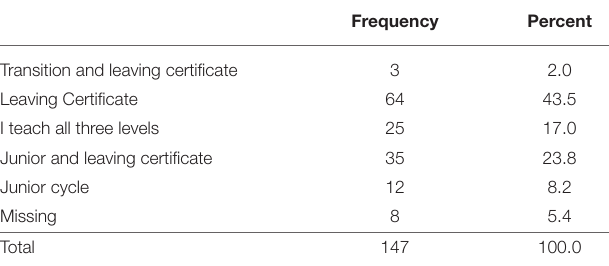
TABLE 3 | Level teachers spend the majority of their time teaching